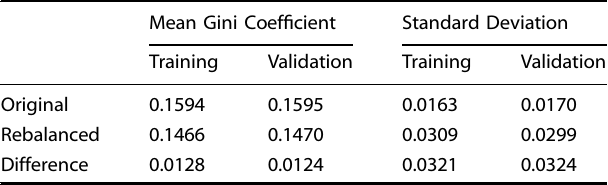
Table 4. Gini coef fi cients. Mean Gini coef fi cients, differences and standard deviations are presented, before and after rebalancing, across n = 10